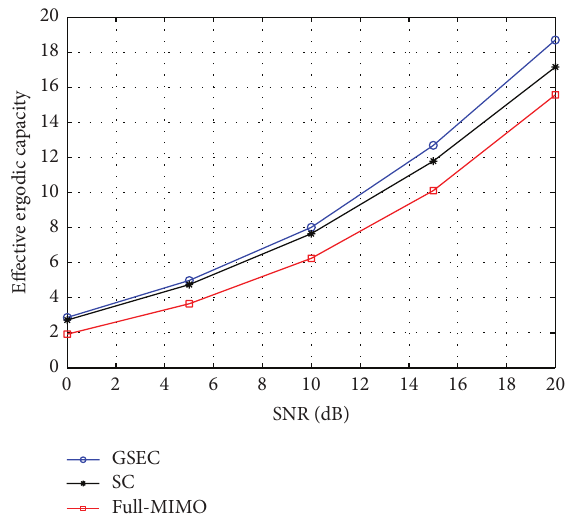
Figure 10: Effective ergodic capacity when 𝑇/Δ = 250 ( 𝑁 𝑇 = 6 , = 30 , 𝐿 = 6 , 𝐷 = 𝐷 = 2𝜆 𝑁 𝑅 𝑅 𝑇 𝑅